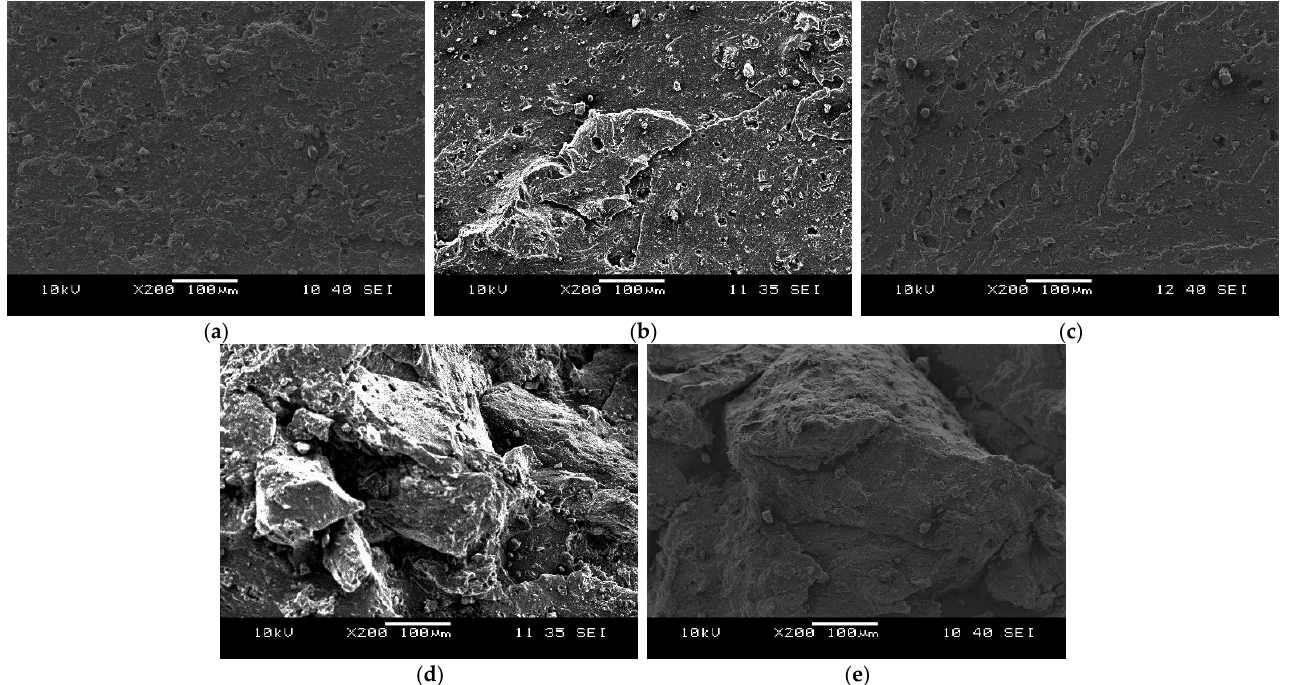
Figure 8. SEM micrographs of the fracture surfaces of the revulcanisates: ( a ) EPDM_neat; ( b ) rev_mix_25; ( c ) rev_mix_50; ( d ) rev_mix_75; ( e ) rev_mix_100.